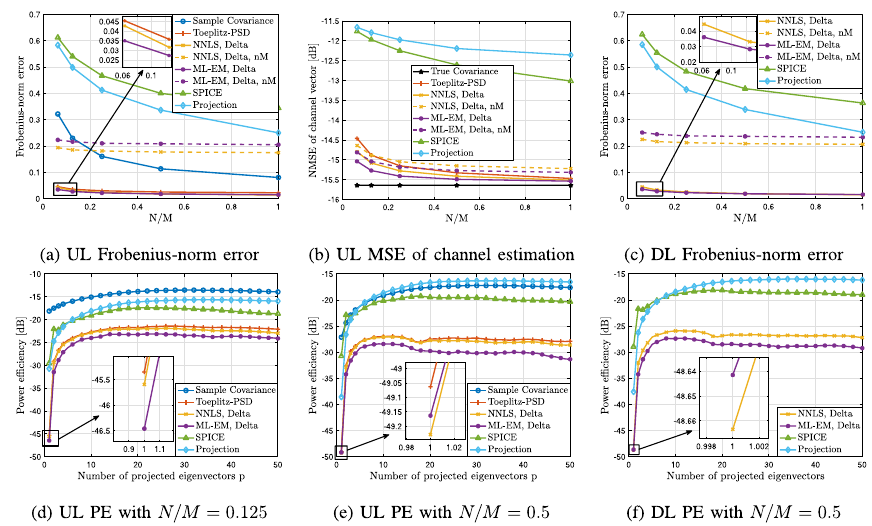
Fig. 6 Covariance estimation quality comparison for scenario